Question: What kind of plot is shown here?
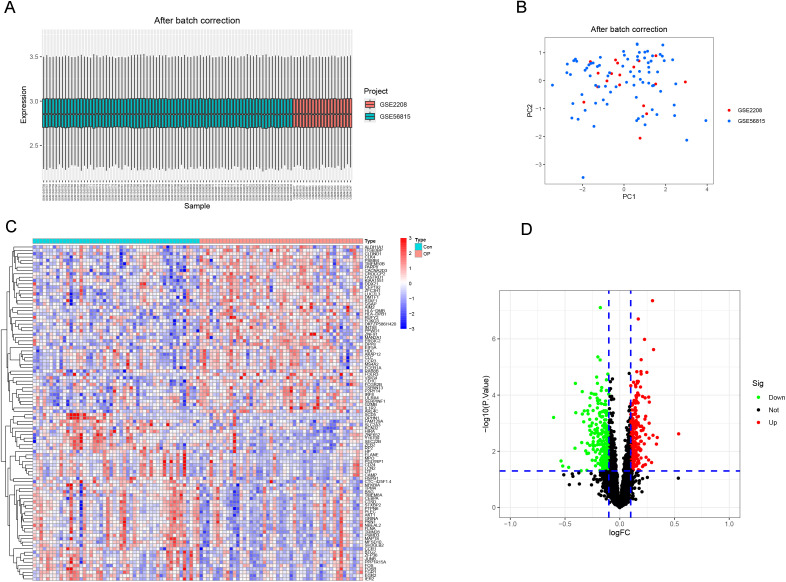
Answer: heatmap